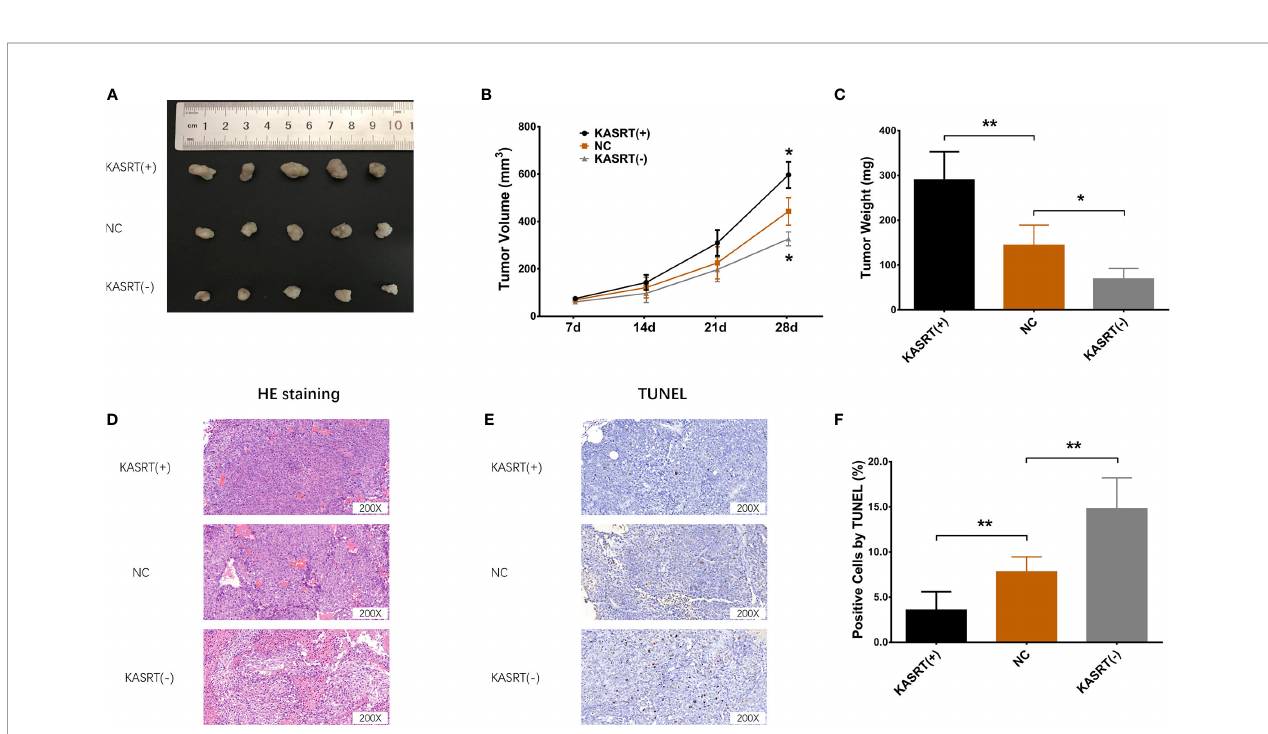
FIGURE 8 | P21/CCND1 pathway in compensatory experiments. In compensatory experiments, P21 and CCND1 mRNA and protein expression among the groups of U-2OS cells (A – C) and Saos-2 cells (D – F) . *P < 0.05, **P < 0.01.